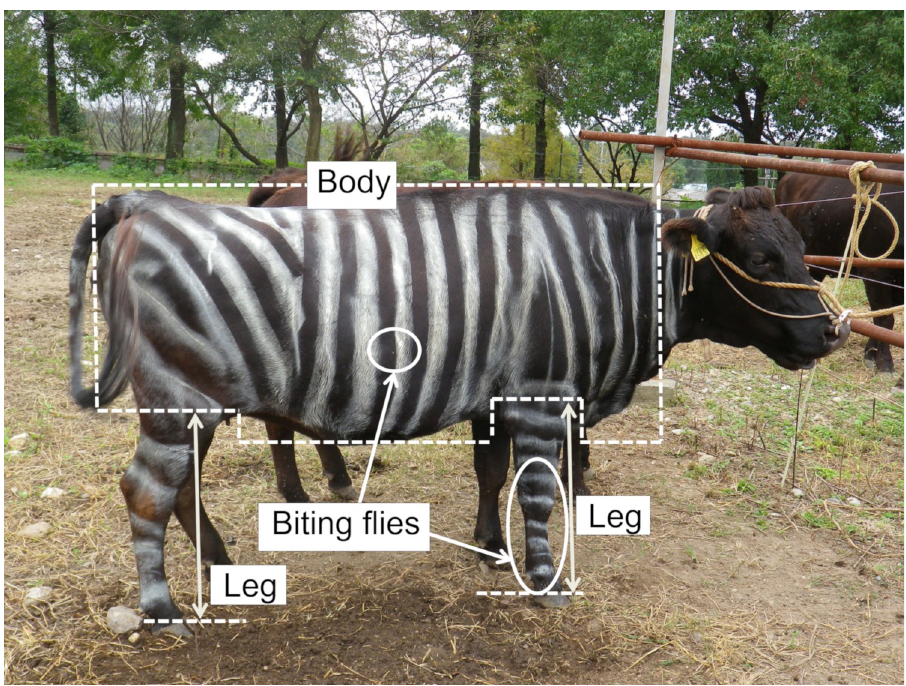
Fig 2. Example of the area of legs and body used to count biting flies on